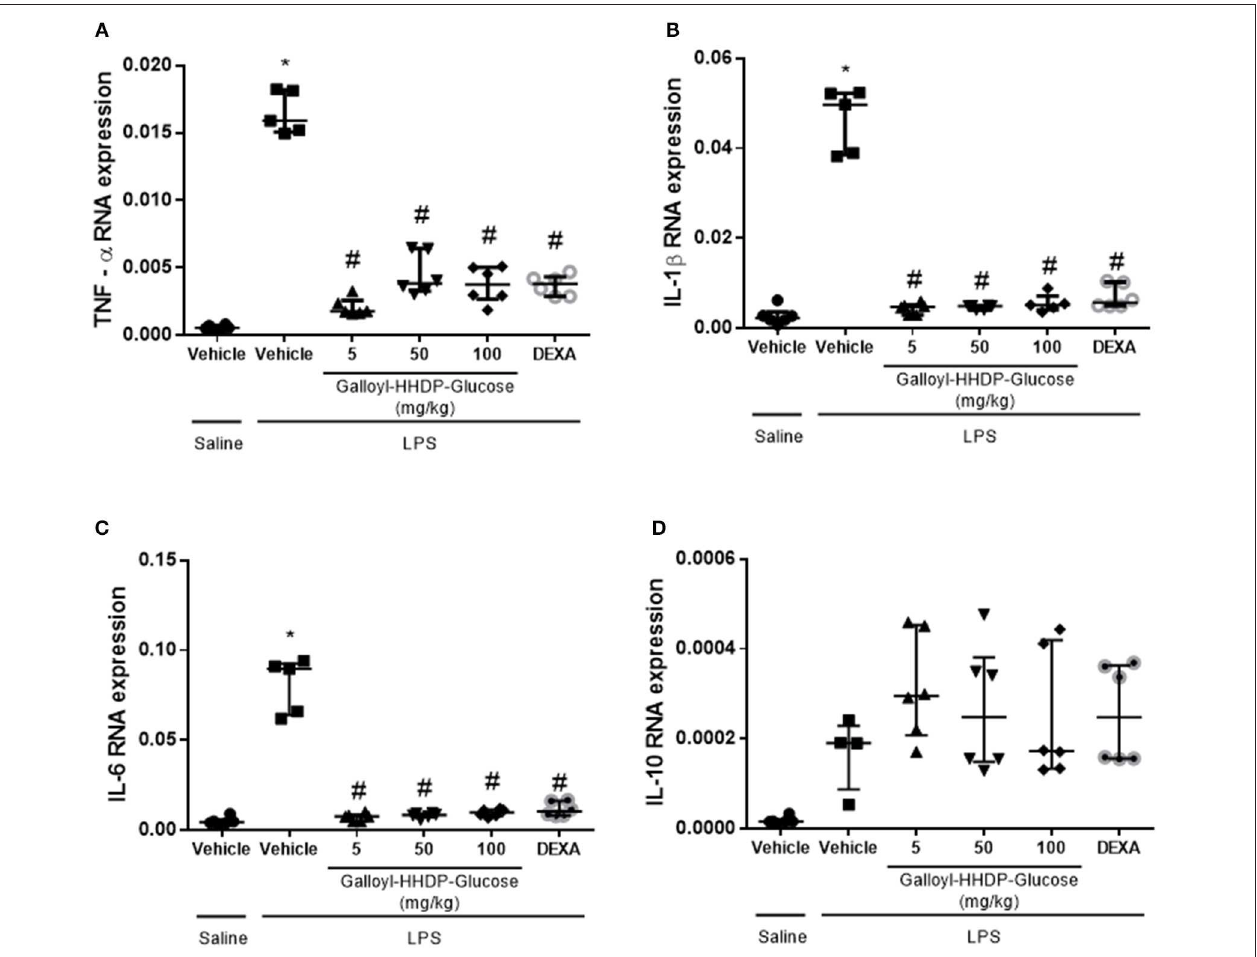
FIGURE 3 | Effects of galloyl-HHDP-glucose treatment on TNF- α (A) , IL-1 β (B) , IL-6 (C) , and IL-10 (D) gene expression in isolated lung tissues of BALB/c mice. BALB/c mice were randomly allocated to 6 groups ( n = 6/group). Mice received galloyl-HHDP-glucose (5, 50, and 100 mg/kg; p.o), dexamethasone (DEXA; 5 mg/kg; p.o), or vehicle (PBS; p.o). The values are presented as median and interquartile range. Significances were calculated by Kruskal–Wallis followed by Dunn multiple comparison test analysis of the groups vs. saline-injected non-treated mice (* p < 0.05) and vs. lipopolysaccharide (LPS)-installed non-treated mice ( # p <